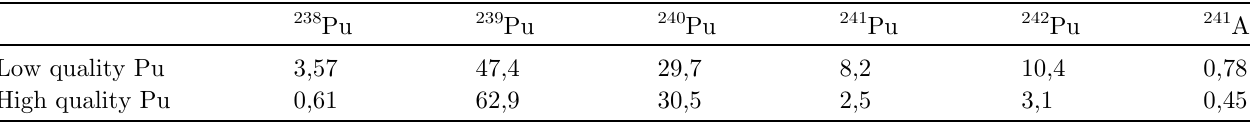
Table 2. High and low quality plutonium content isotopic vector used here.